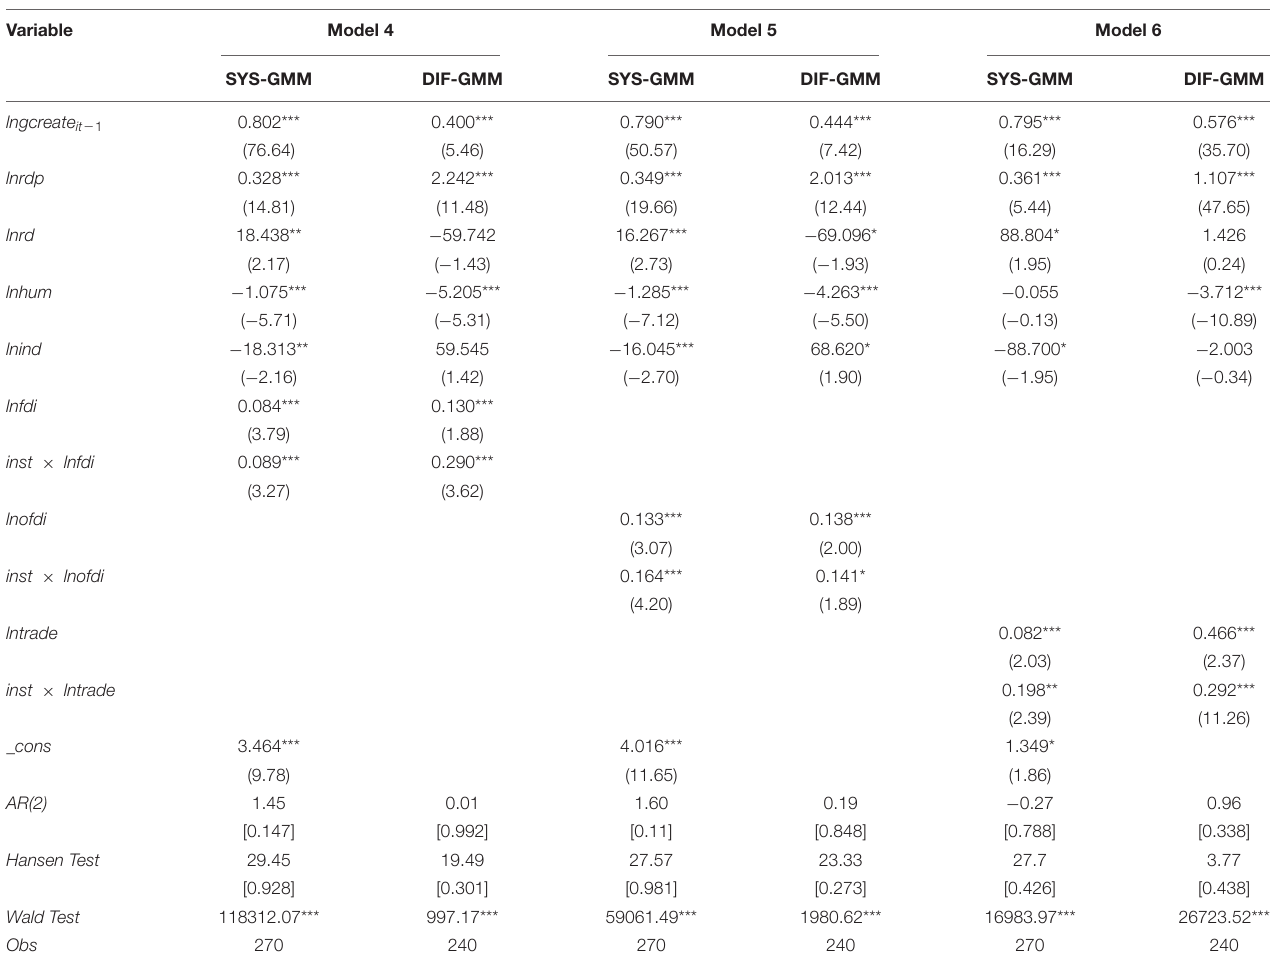
TABLE 5 | Regression results of interaction effects.